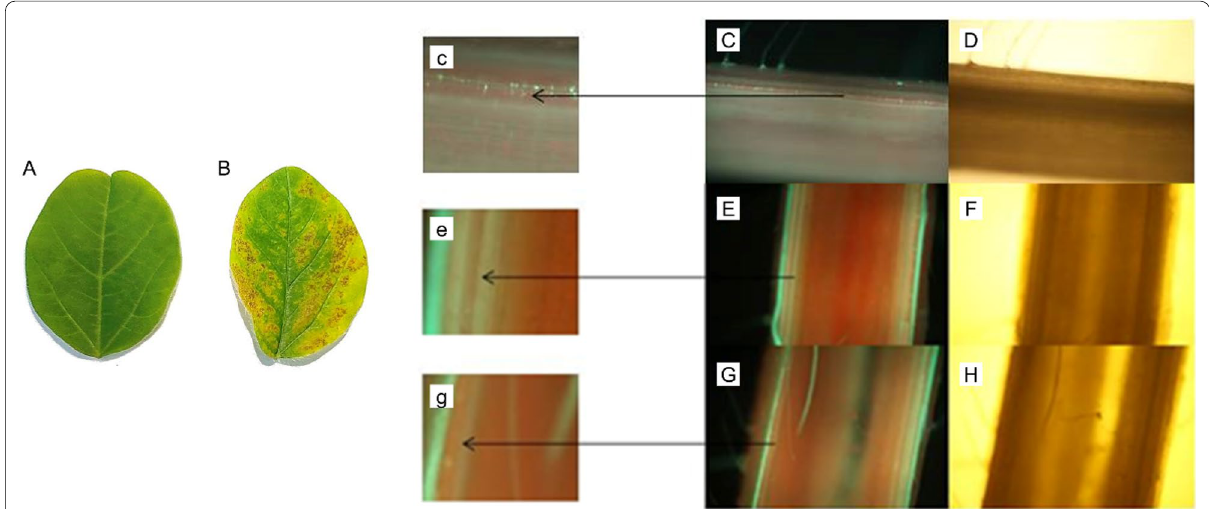
Fig. 4 Callose in rootstock stem when scion was inoculated with SMV. A Non-inoculated upper leave of the rootstock; B Scion leaves inoculated with SMV; C Callose fluorescence was detected in stem of rootstock below the grafting site at 3-days after scion nf58 was frictionally inoculated with N3; D micrograph of C under transmission light; E Callose fluorescence was not detected in stem of rootstock above the grafting site at 3 days after scion nf58 was frictionally inoculated with N3; F micrograph of E under transmission light; G Callose fluorescence was not detected in stem base of the rootstock Wuxing 2 at 3-days after scion Jihuang 13 was frictionally inoculated with SC-8; H micrograph of ( G ) under transmission light; c, e, and g: the enlarged pictures of the areas labeled with arrows in picture C, E, and G